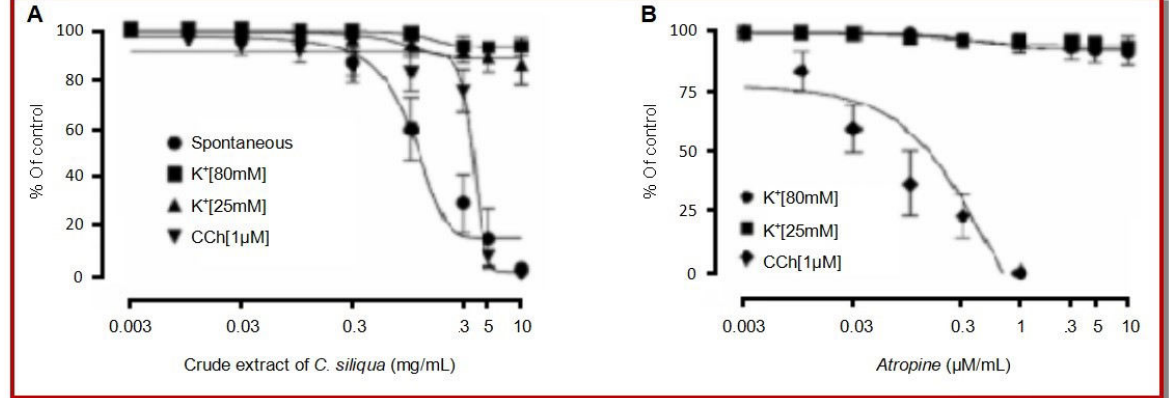
Figure 1: (A) Inhibitory effect of crude extract of C. siliqua on spontaneous, high-K, low-K, carbachol (1 µM)-induced contraction in segregated rabbit jejunum. (B) Effect of atropine on high-K, low-K and carbachol (1 µM)-induced contraction in segregated rabbit jejunum.